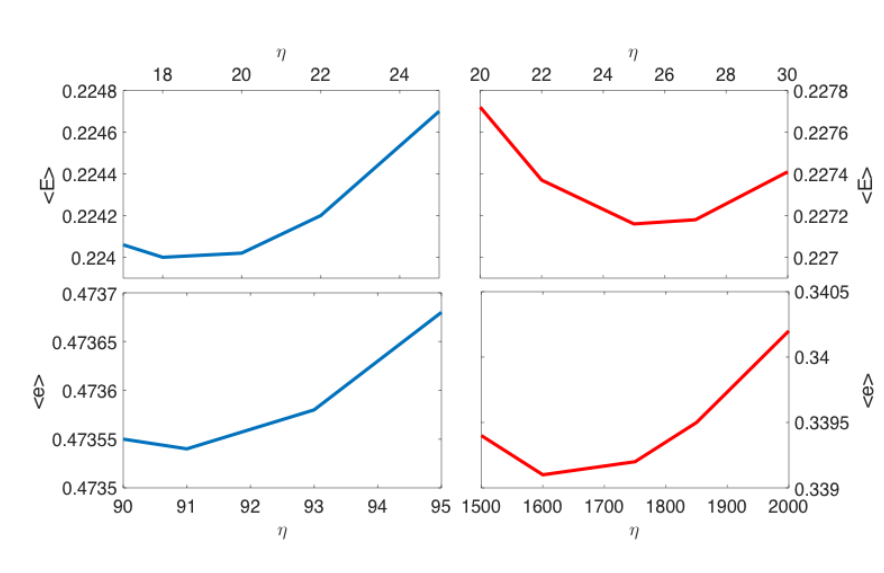
Figure 4. Optimisation of the smoothing parameter η : average root mean squared error (cid:104) E (cid:105) and average end-point error (cid:104) e (cid:105) as functions of the smoothing parameter η . We show both scenarios when the error’s correlation is taken into account (blue) or completely ignored (red). The minimum illustrates the existence of the optimal value of η that minimises the error and shows that incorporating the error’s correlation does not significantly improve the filter’s performance.